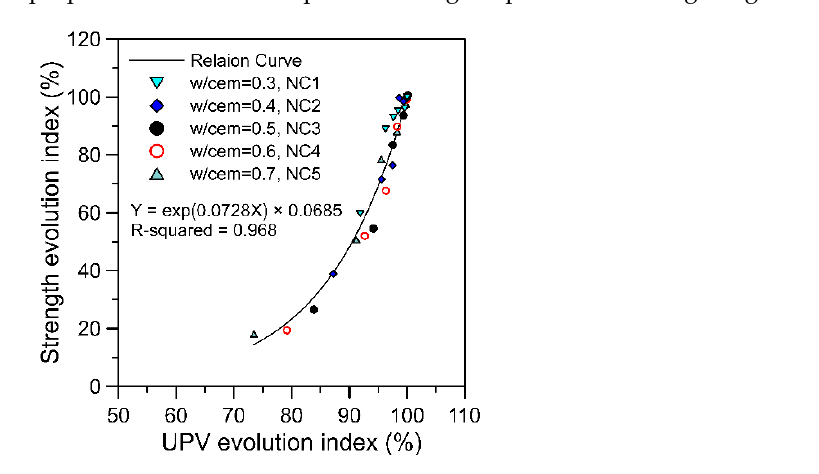
Figure 3. Relationship between the UPV evolution index and the strength evolution index of normal concrete. mal concrete.